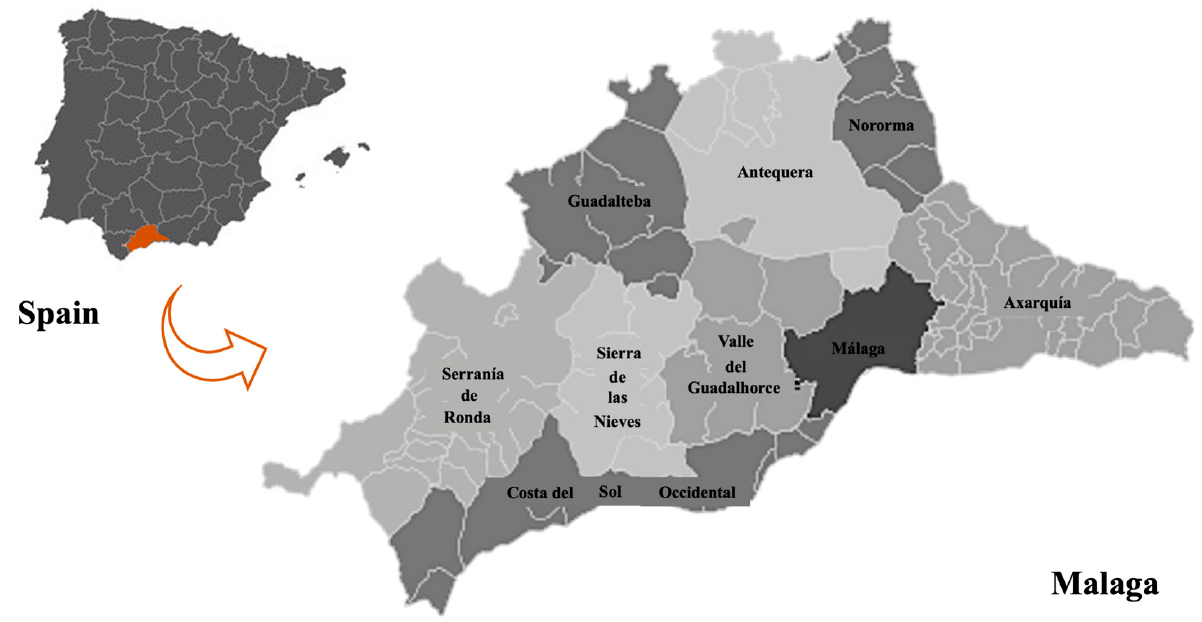
Figure 1. The map of the administrative divisions of the province of Malaga has been enlarged to show the 9 sectors where the sampled playgrounds were located. The localisation of the province of Malaga in Spain is highlighted in orange in the upper left corner.